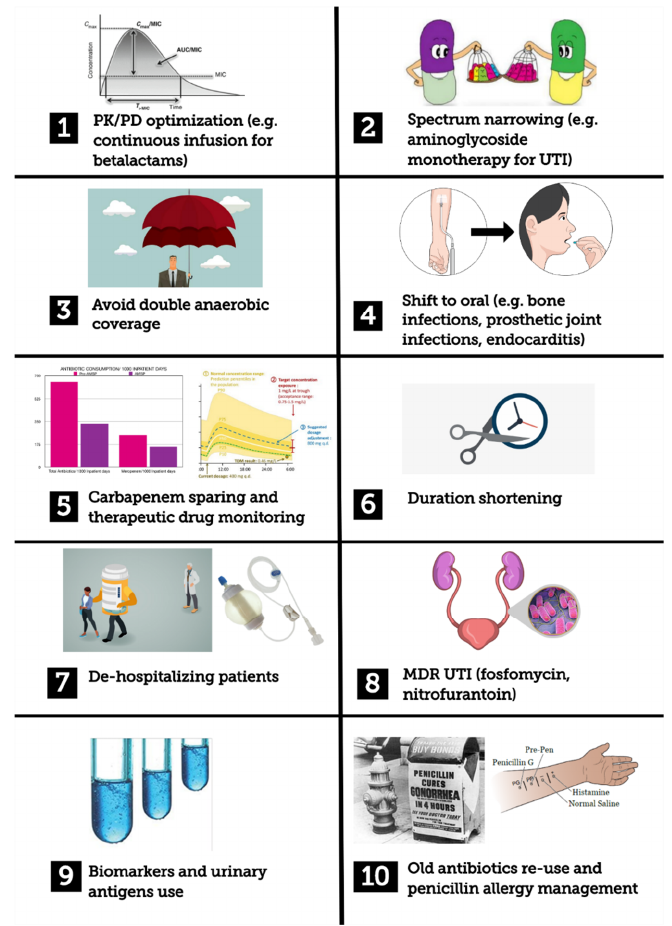
Figure 1. Graphical summary of stewardship interventions described in the manuscript. MDR: multidrug resistant; PK/PD: pharmacokinetic/pharmacodynamics; UTI: urinary tract infection